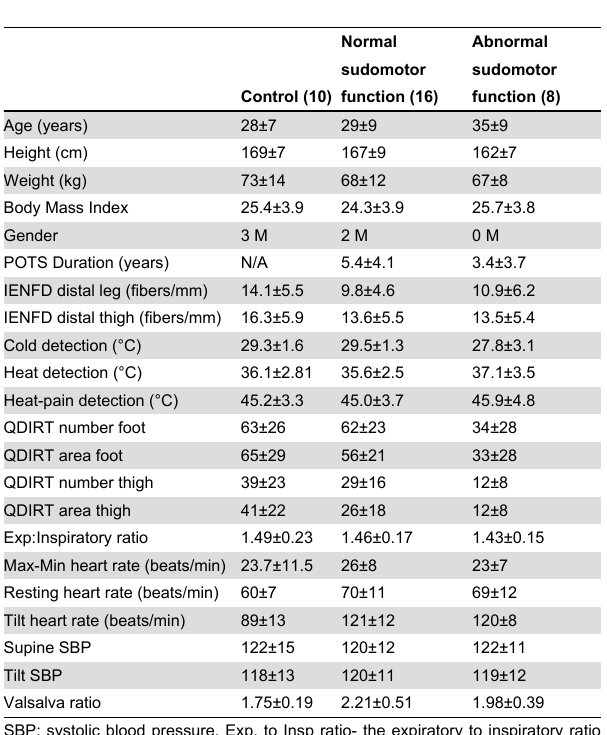
SBP: systolic blood pressure. Exp. to Insp ratio- the expiratory to inspiratory ratio during deep breathing.Intra-epidermal nerve fiber